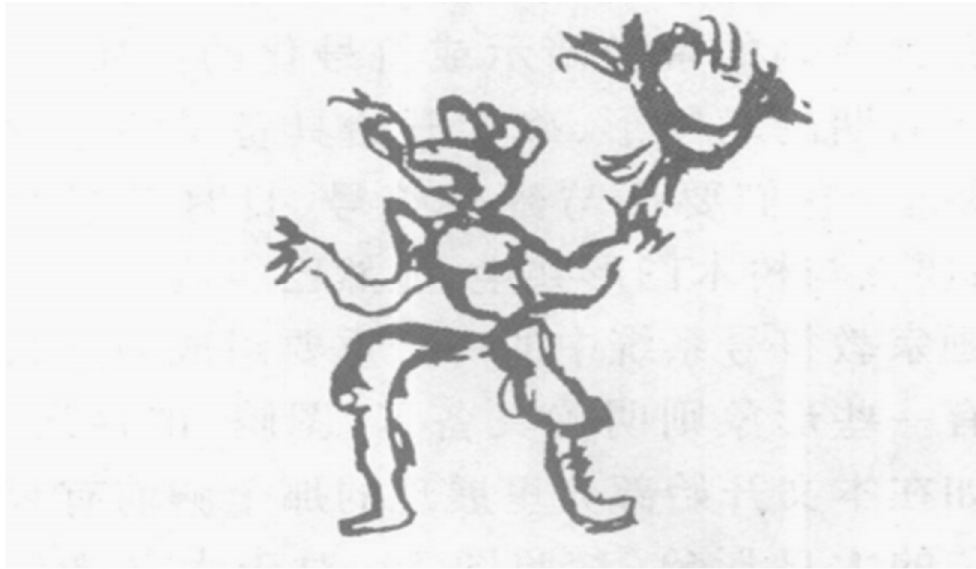
Figure 1. People worship at an altar wearing the representative of the original Bön 苯教 shaman of the bya-ru 甲茹 (rock painting from Zhaxi Island, Namucuo, northern Tibet 纳木错扎西岛 ) (Zhang 2006, p. 55).